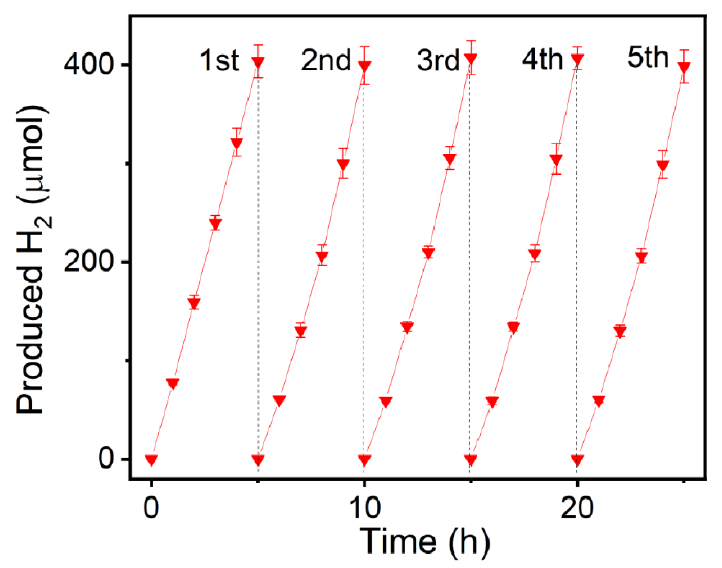
Figure 10. Reusability of 10% BP/KPHI catalyst for evolving H 2 over five successive experimental runs.